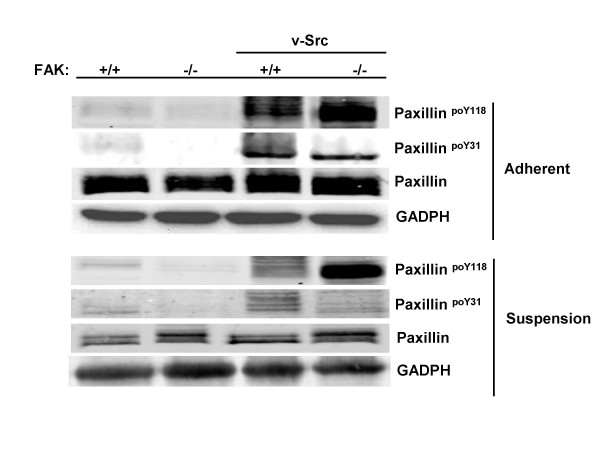
Enhanced v-Src-induced paxillin phosphorylation is attenuated by FAK. Lysates from adherent or suspension cultures of FAK+/+[puro], FAK-/-[puro], FAK+/+[v-Src] and FAK-/-[v-Src] cells were probed by IB for total paxillin, paxillinpoY31, paxillinpoY118 or GAPDH. These data are typical of at least three independent experiments.